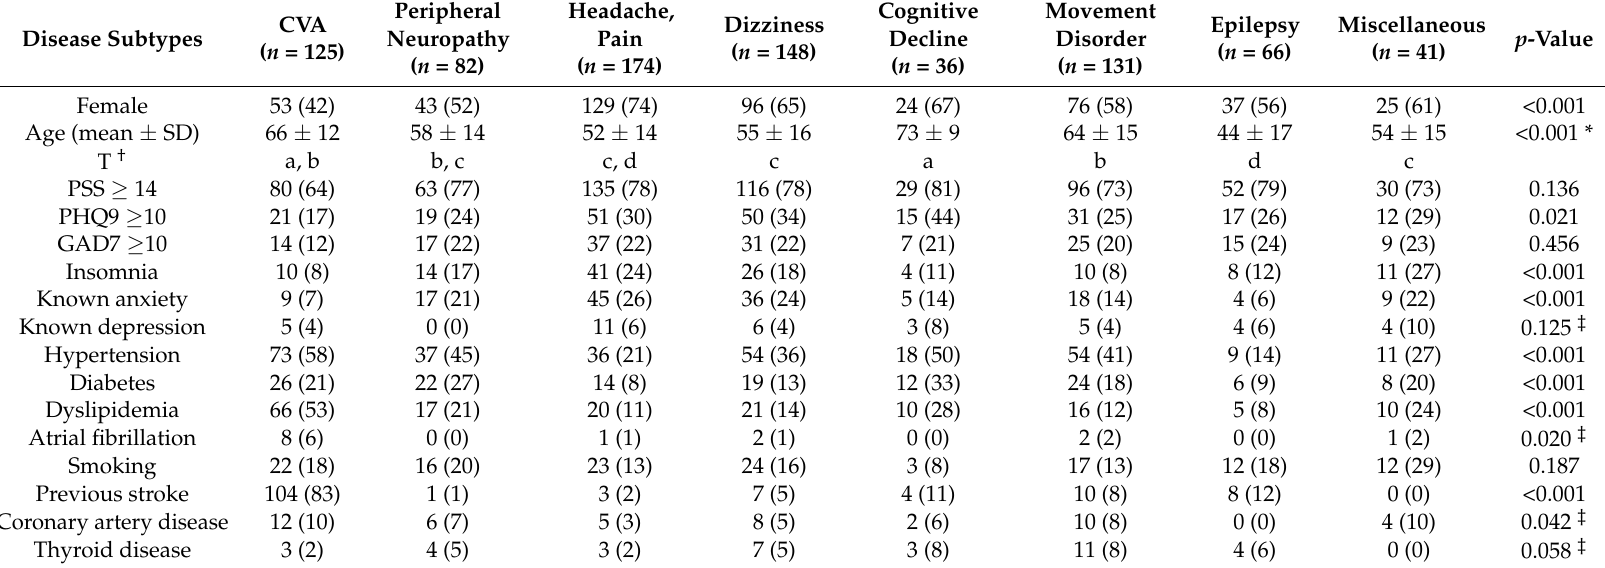
Table 1. Differences in frequency and descriptive statistics across disease subtypes 1